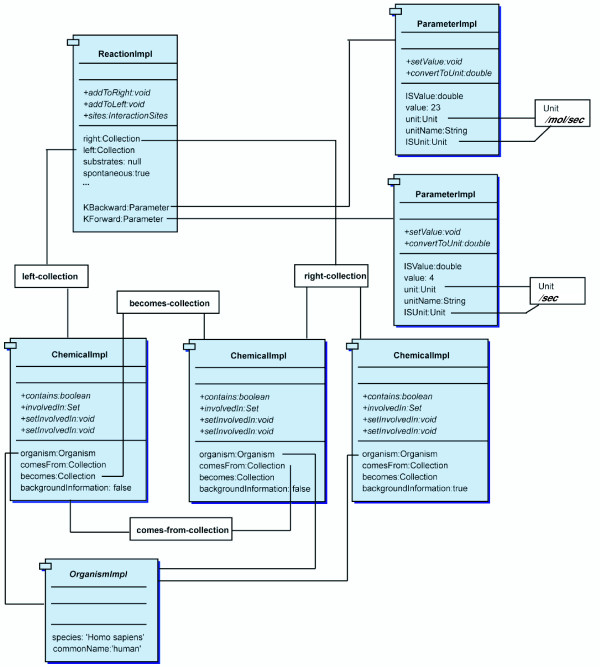
Instance graph for representation of a reaction between three chemicals (e.g., A ↔ B + C). Some of the relationships that support navigation from reactions to chemicals are shown, as well as links between chemicals. The three chemicals are produced by the "human" organism. Quantitative kinetic parameters are also shown for the reaction (backward and forward rate of the reaction). The figure illustrates how a graph of object instances is used to represent biological information corresponding to a biochemical reaction.